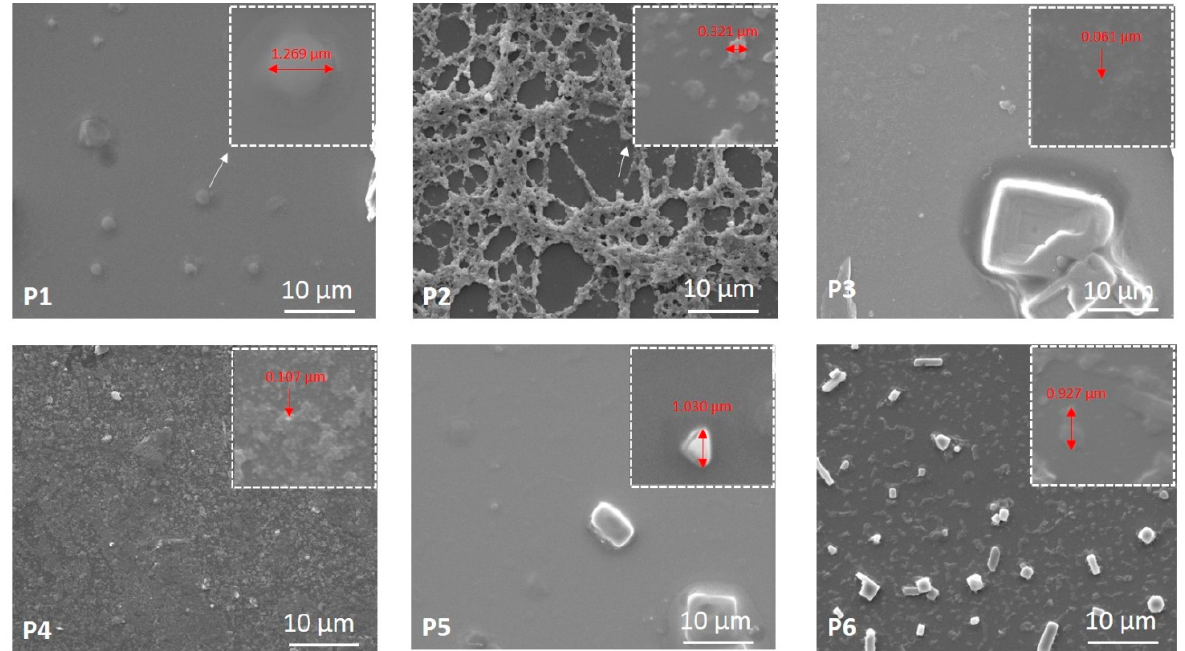
Figure 7. SEM images of the developed materials. Magnified SEM images of 3 × 3 µm 2 are also presented, in which various particle sizes are measured.